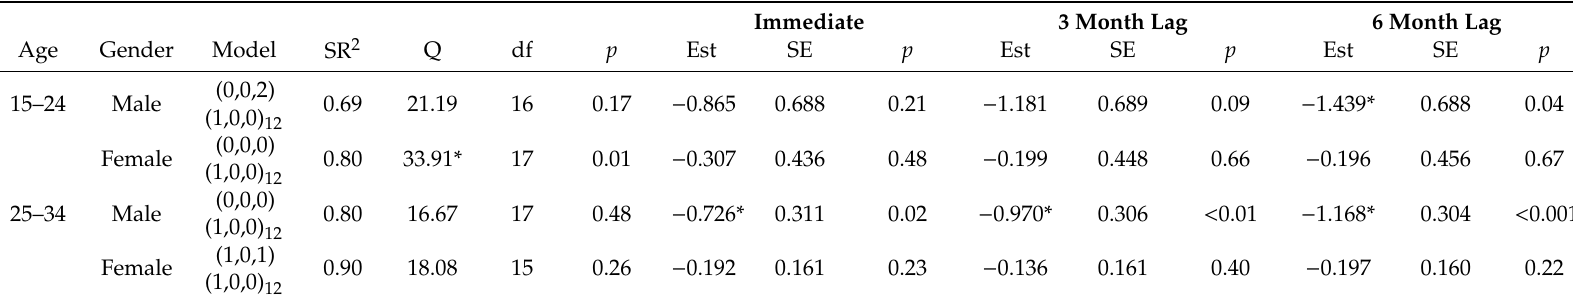
Table 3. ARIMA model results of the association between introduction of the alcopops tax and monthly chlamydia test positivity rates (secondary outcome) by age group and gender, July 2000 to December 2016.